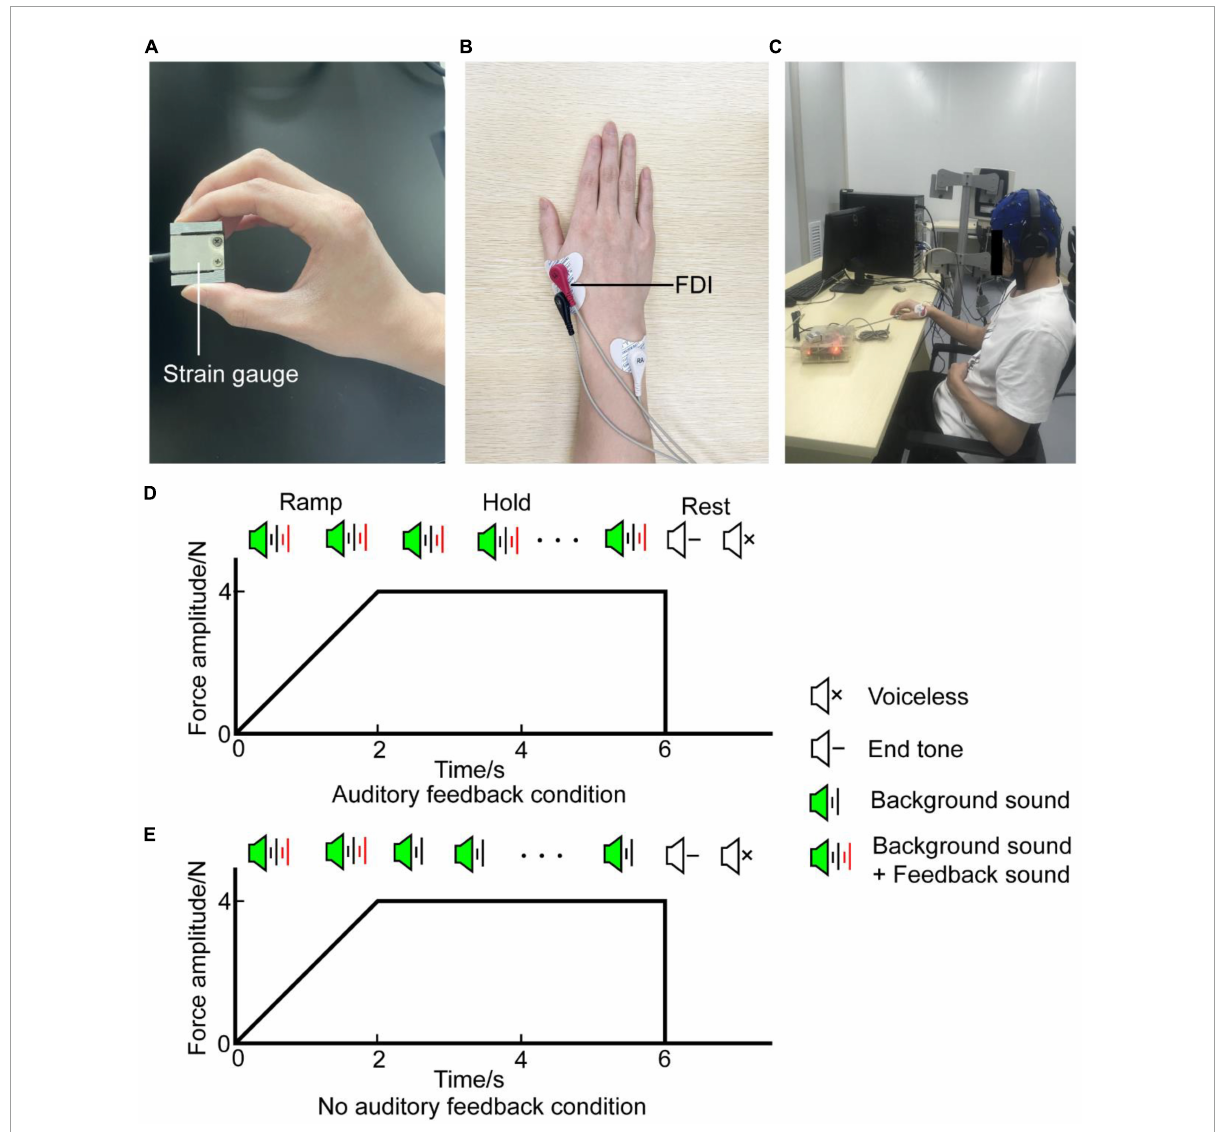
FIGURE1 Experiment setup. (A) Precision grip strain gauge held between the thumb and index finger by the participant during the task. (B) EMG signal was obtained from the rFDI muscle. (C) The participant was seated in an armchair with an EEG cap. (D) Diagram of auditory feedback condition. A task with auditory feedback during the steady-hold period. (E) Diagram of no auditory feedback condition. A task without auditory feedback during the steady-hold period. In (D,E) , the horizontal axis means the time, the vertical axis means the force amplitude. Each trial was composed of a ramp period and a steady-hold period. The ramp period lasted from 0 to 2 s, the steady-hold period lasted from 2 to 6 s. After a rest period of about 1.5 s, participants processed the next trial. EMG, electromyography; rFDI, right first dorsal